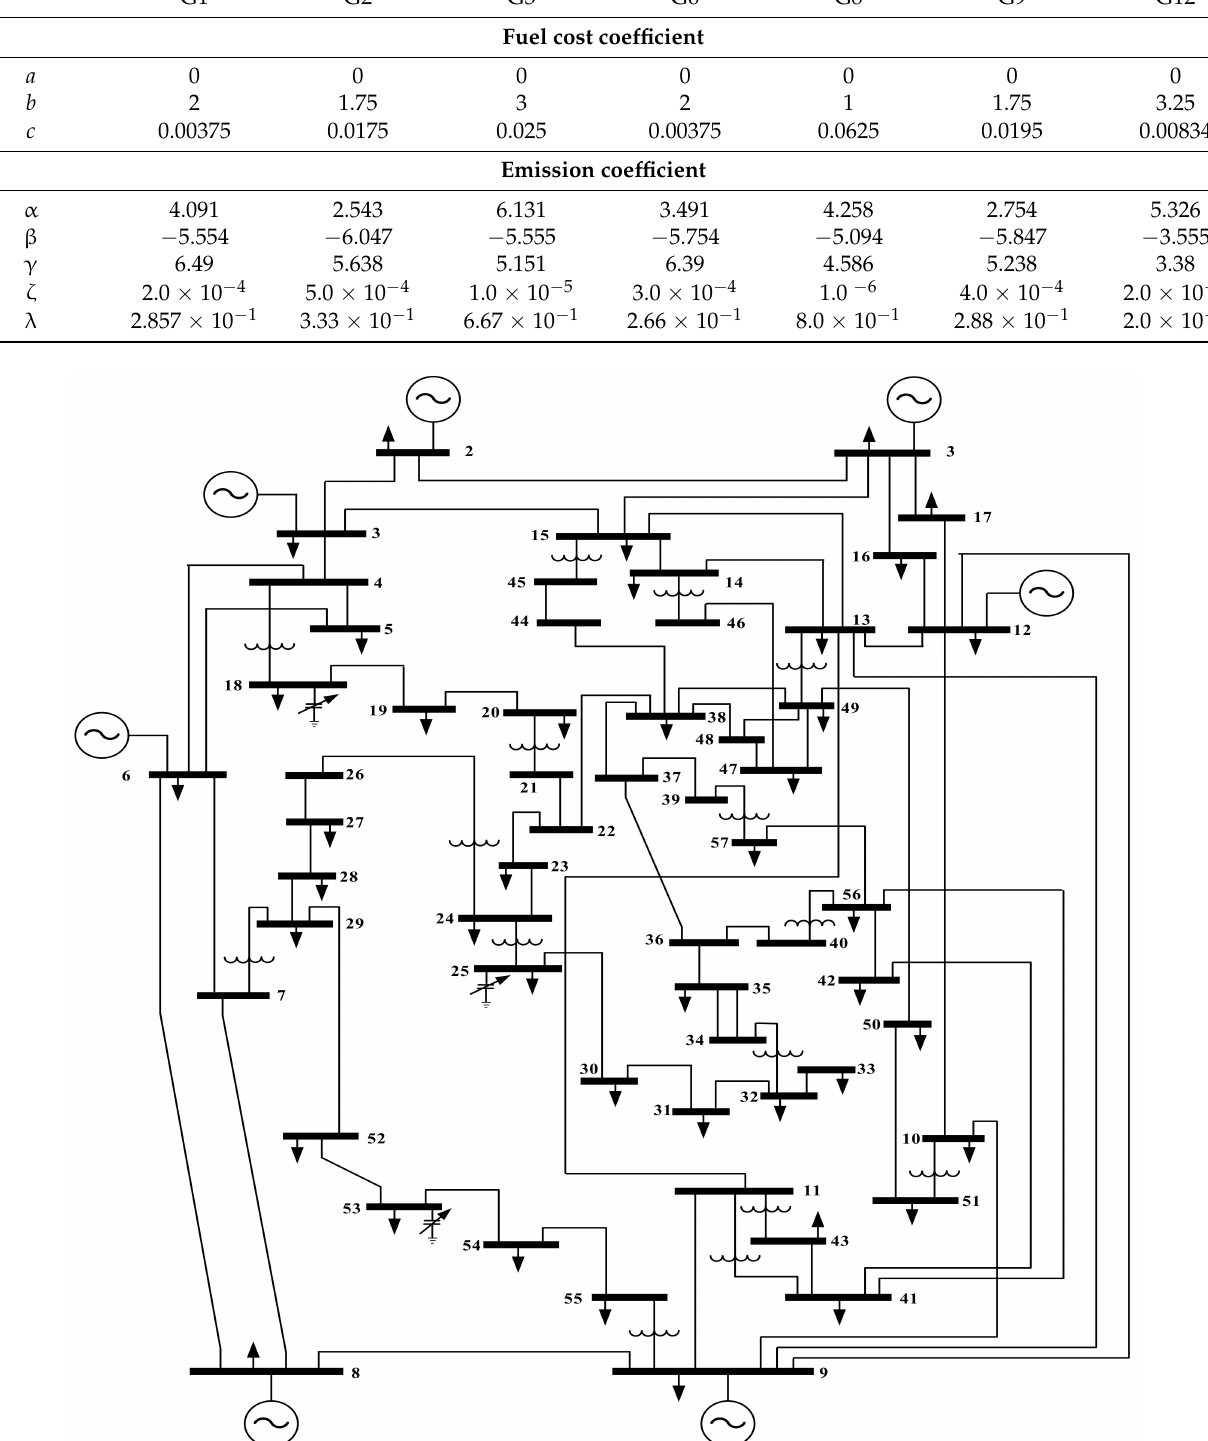
Figure A2. Single-line diagram of the IEEE 57-bus